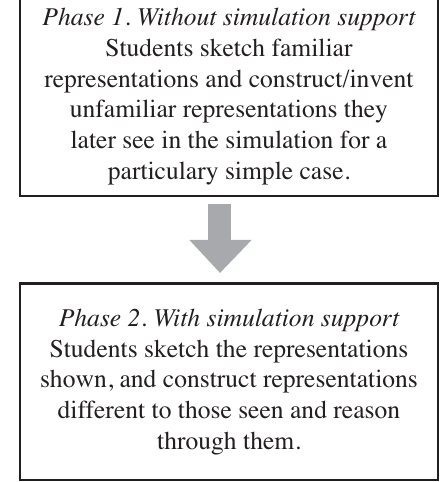
FIG. 2. The two phases of the simulation-tutorial activities discussed in Secs. IVA (phase 1) and IV B (phase